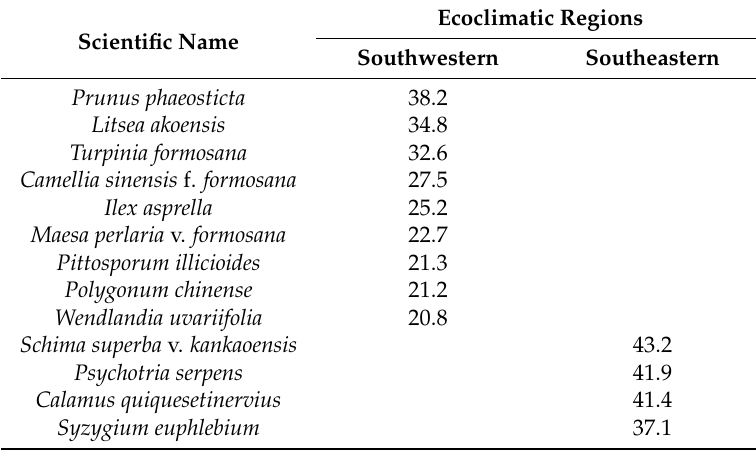
Figure 5. Relevés of different area and environment factors in DCA (1: indicates the relevés of western area of Southern Taiwan; 2: indicates the relevés of eastern area of Southern Taiwan; T1: temperature of January; WP: precipitation in winter; contour line: altitude (m)). Table 3. Diagnostic species of southwestern and southeastern climatic regions. Values are the percentage constancy and species are sorted by decreasing fidelity ( Φ ).